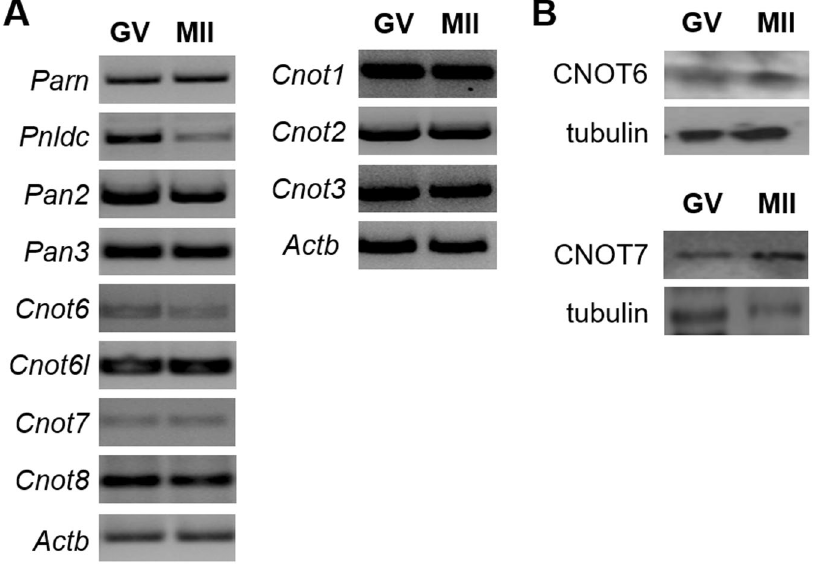
Figure 2. Expression of deadenylases in oocytes. Oocytes were obtained as in Fig. 1. ( A ) mRNAs were assayed using the polymerase chain reaction and the primers shown in Table 2. mRNAs encoding all major deadenylases are present in both immature (GV) and mature (MII) oocytes. Actb is used as a loading control. ( B ) CNOT6 and CNOT7 protein were assayed by immunoblotting using commercially available antibodies. Panels shows representative blots.